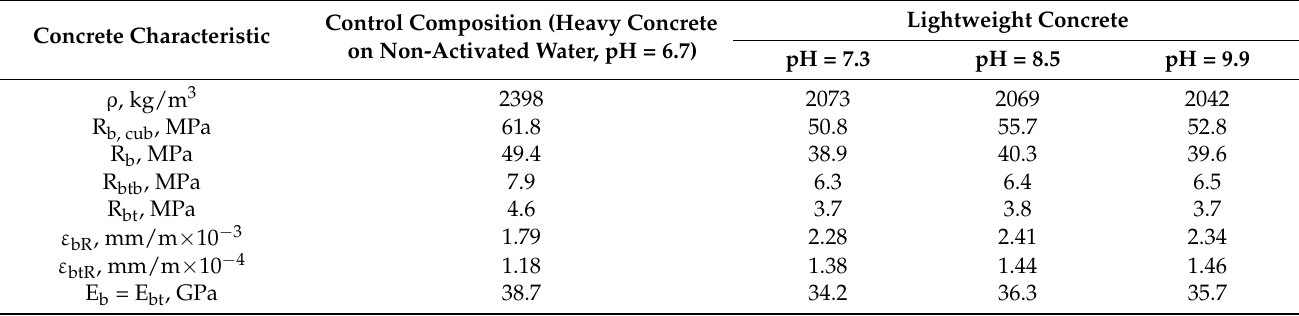
Table 8. Differential strength and deformation characteristics of prototypes of vibro-centrifuged concrete.